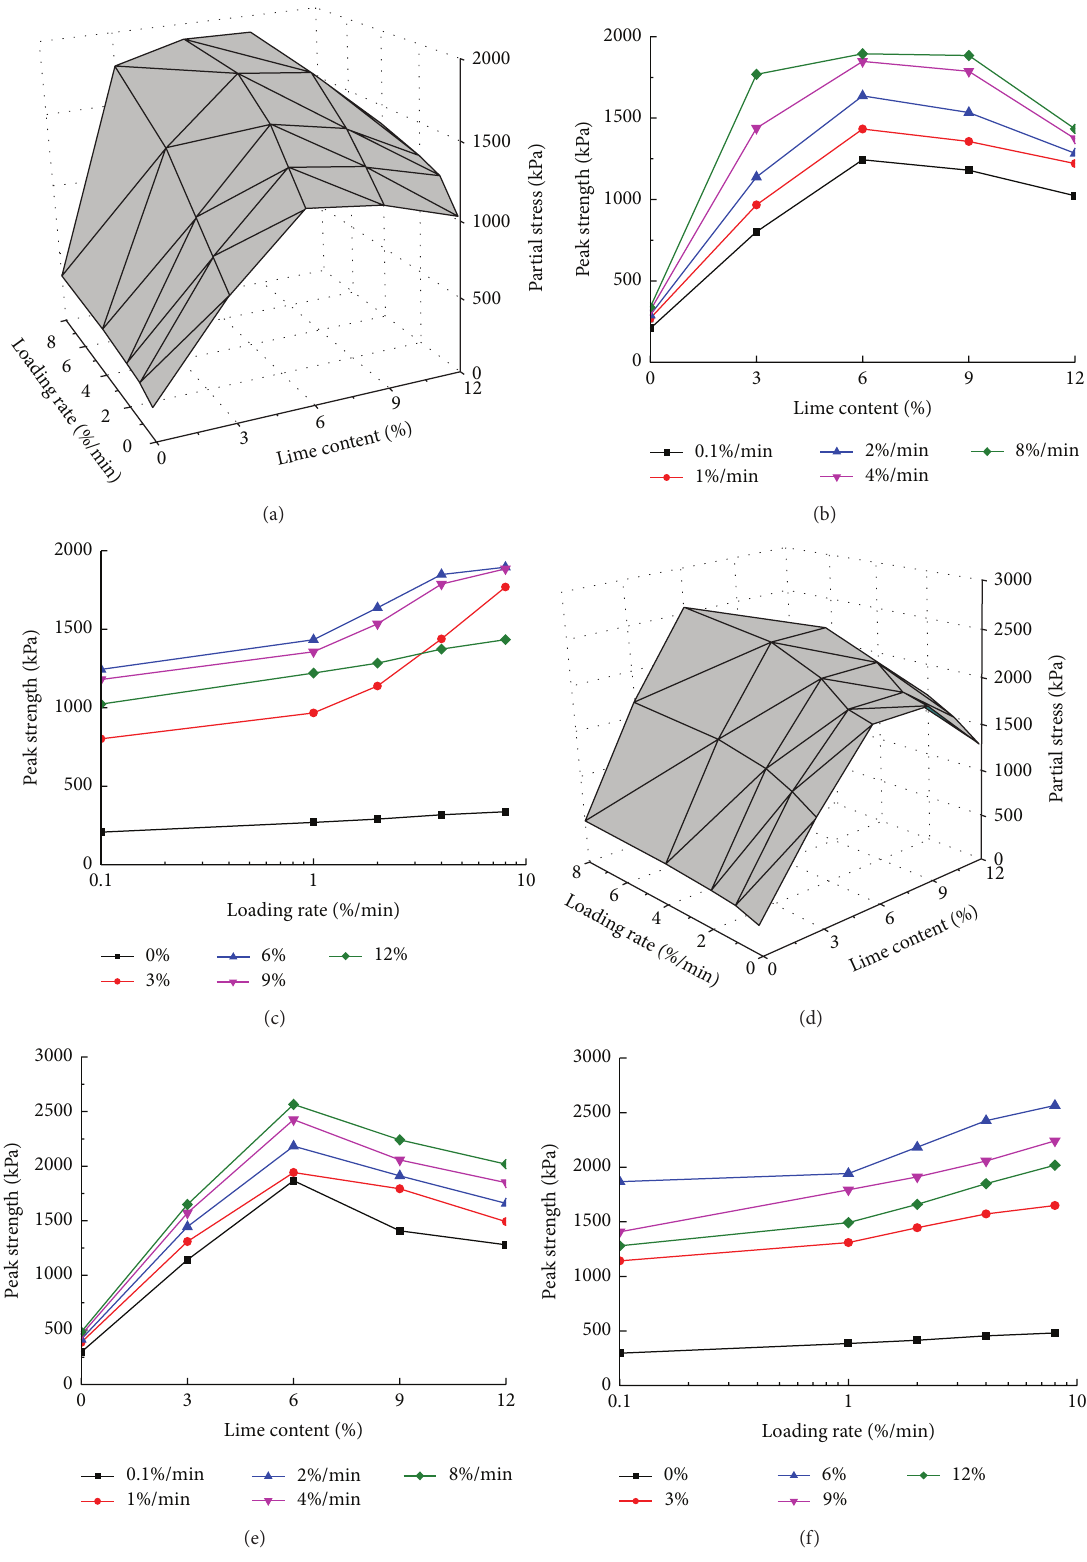
Figure 4: Relation between shear strength and lime content and loading rate of (a) shear strength three-dimensional curved surface (7 days), (b) shear strength lime content (7 days), (c) shear strength loading rate (7 days), (d) shear strength three-dimensional curved surface (21 days), (e) shear strength lime content (21 days), and (f) shear strength loading rate (21